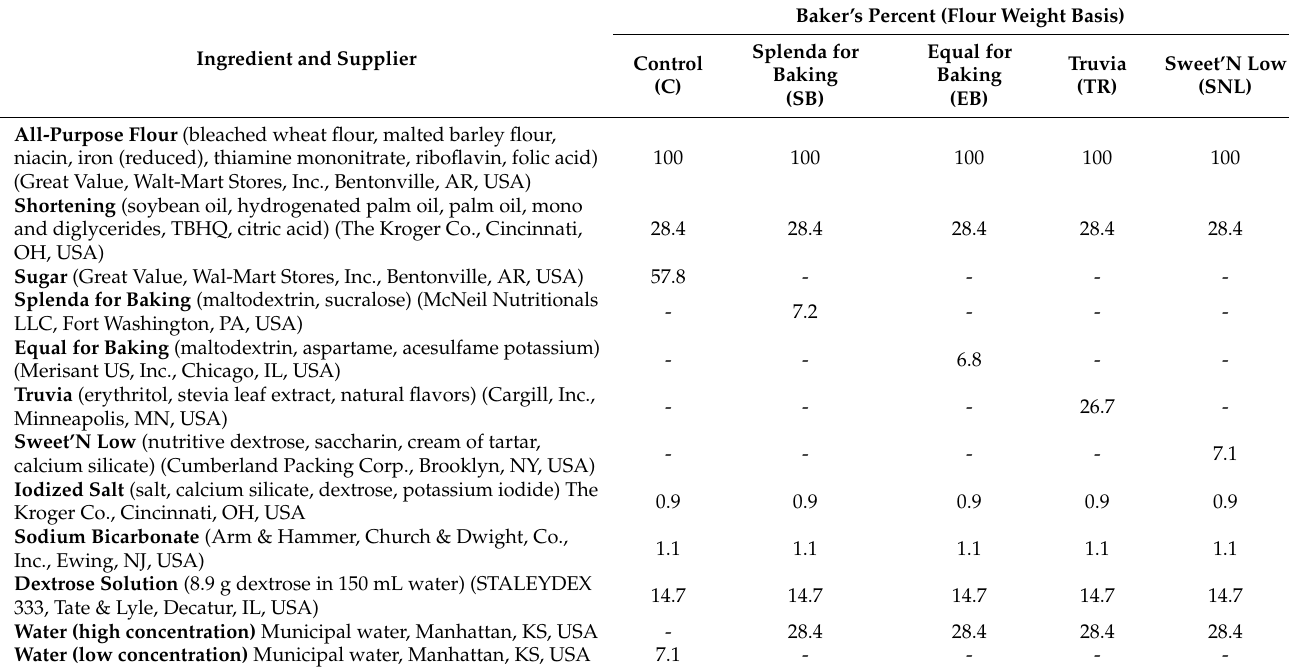
Table 1. Formulation of cookies with 100% sucrose replacement based on relative sweetness level.